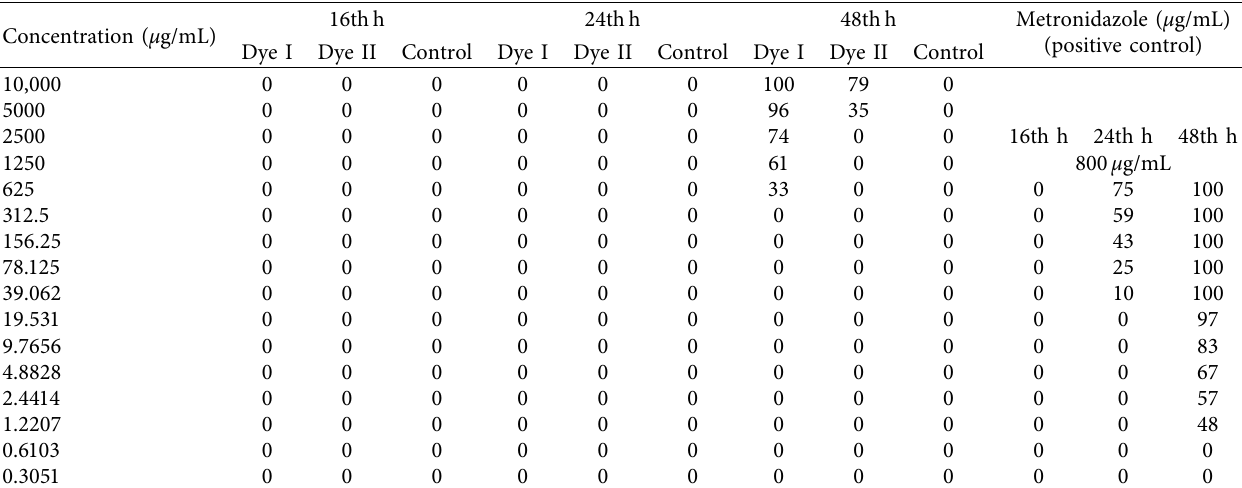
Table 5: Minimum lethal concentration (MLC) values obtained at the end of 16, 24, and 48hours against T. vaginalis trophozoites. 16th h Concentration ( μ g/mL)